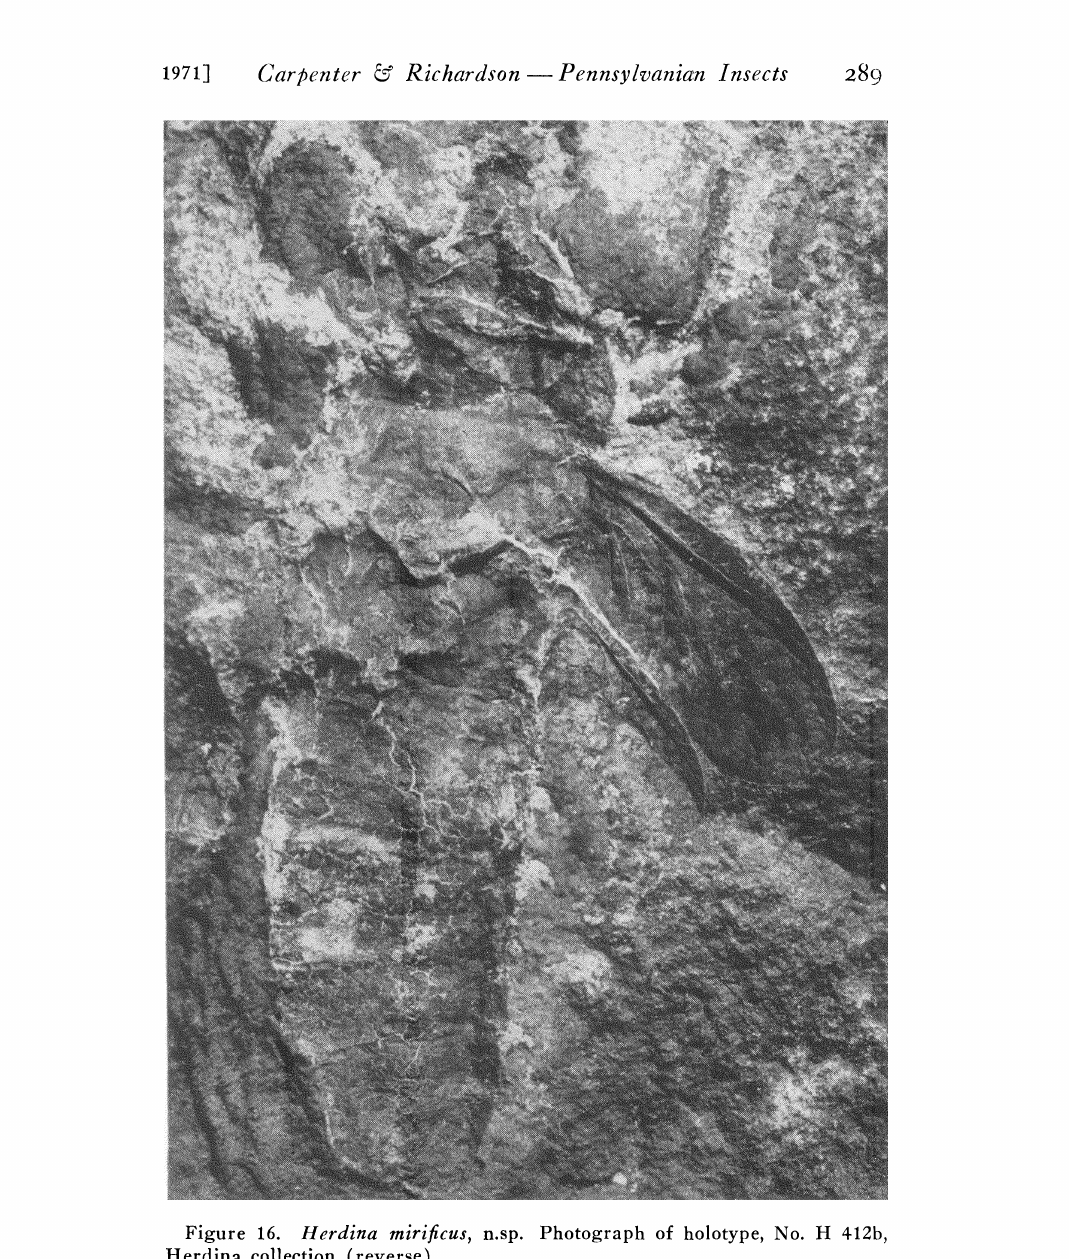
Figure 16. Herdina mirificus, n.sp. Photograph of holotype, No. H 412b, Herdina collection